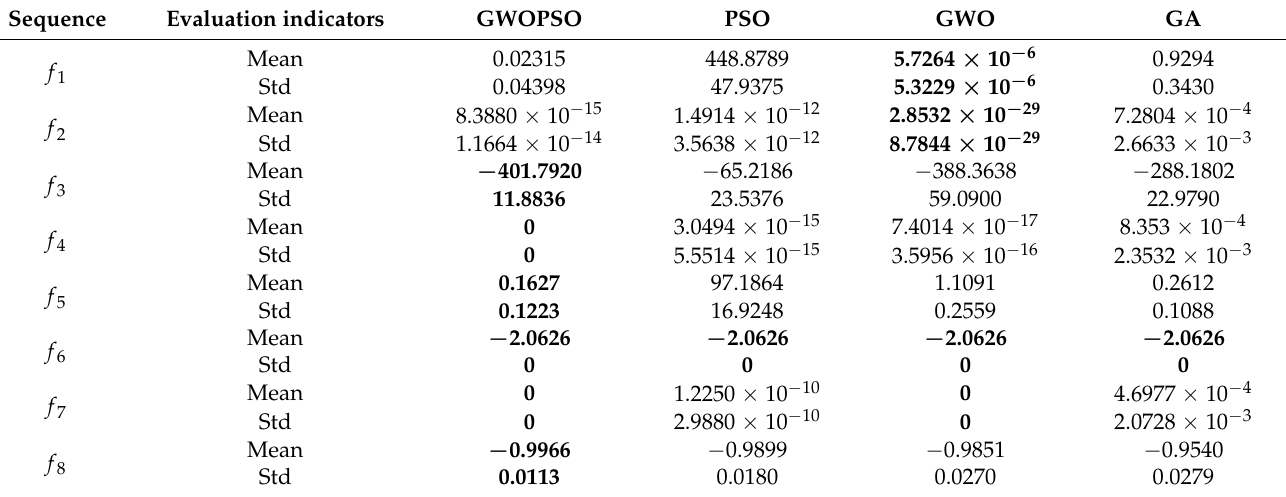
Table 5. Results of benchmark